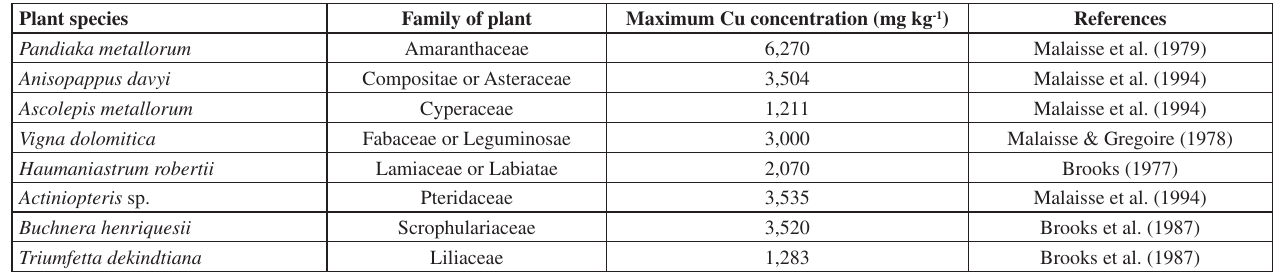
Table 3: Some hyperaccumulators of copper from Democratic Republic of Congo (Zaire) Plant species Family of